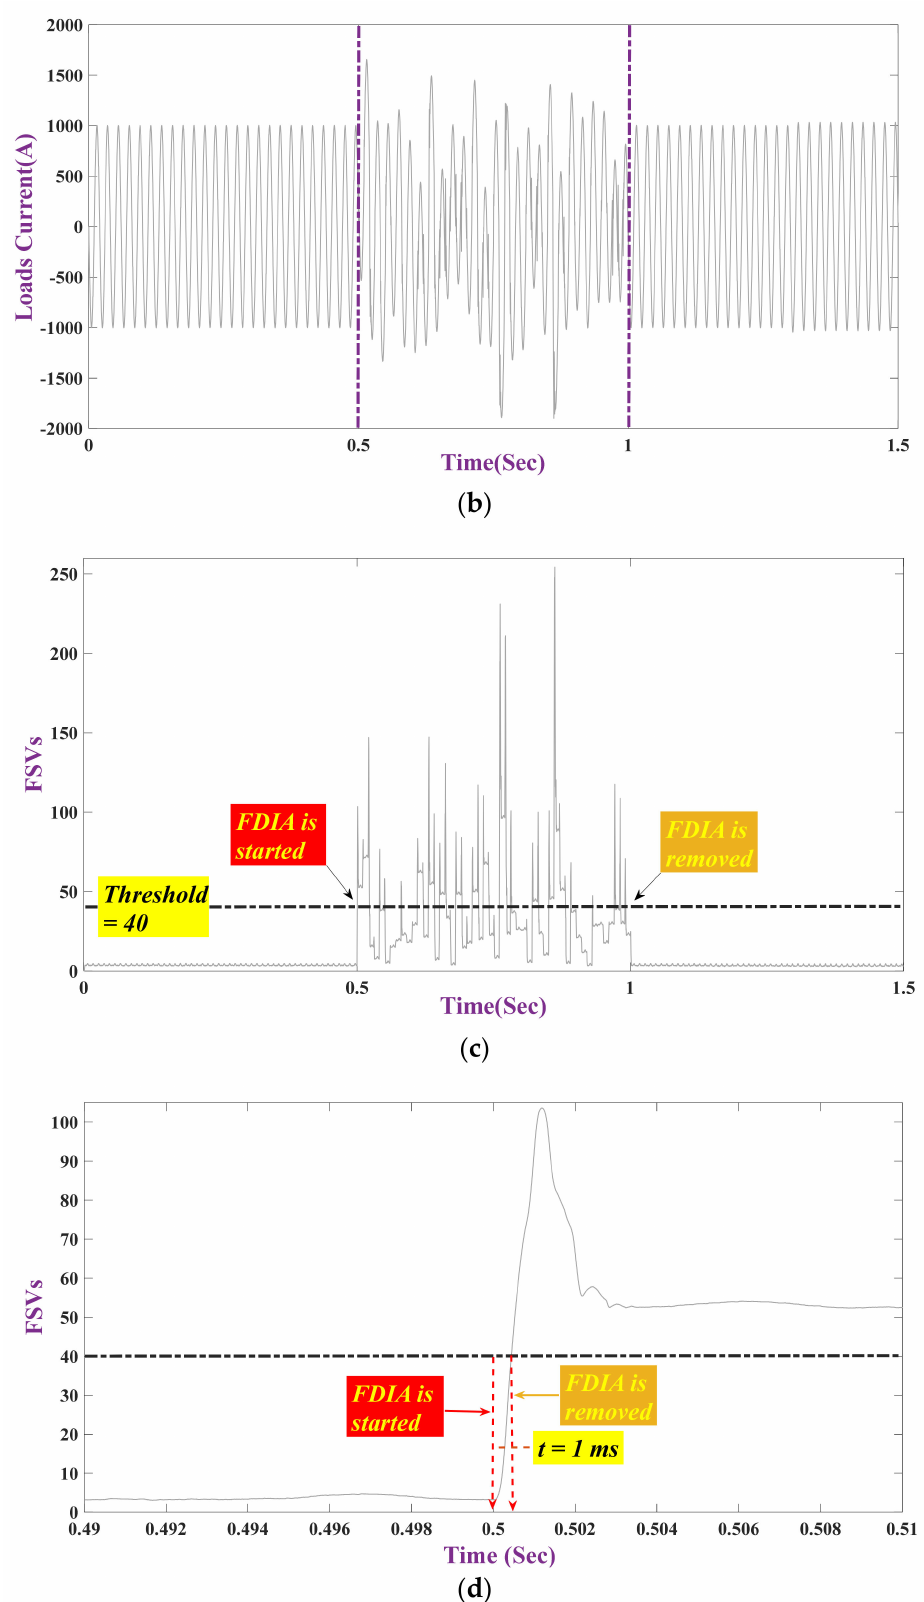
Figure 8. Instability stems from manipulating the voltage reference signal through plus noise to the main signal: ( a ) ISMG’s voltage; ( b ) Loads current; ( c ) FSVs of signals; ( d ) Time response of FSV’s scheme (FDIA is initiated at t = 0.5 s and is omitted at t = 1